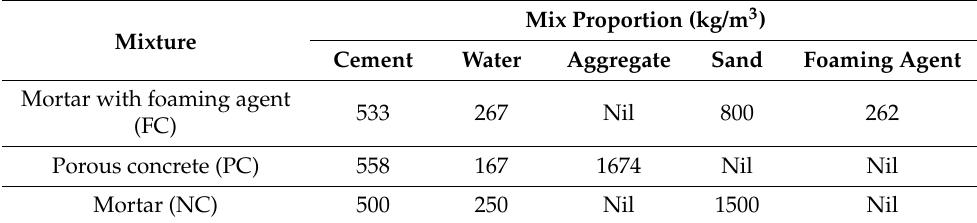
Table 1. Composition of materials used for FC, PC and NC.